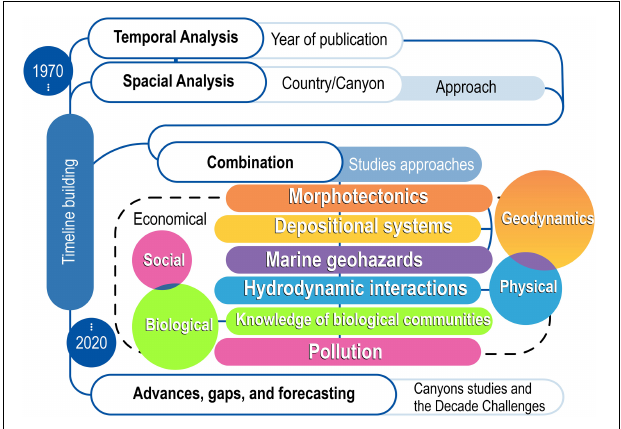
FIGURE 1 | Methodological flowchart with the development steps and visualization of the results